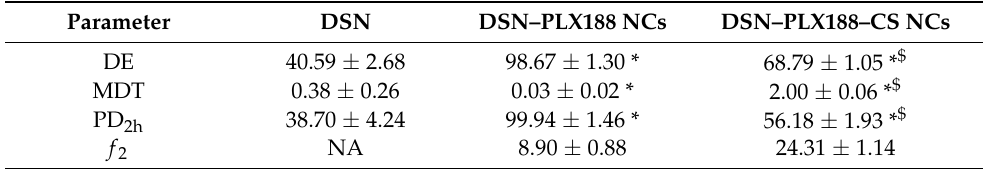
Figure 5. In vitro DSN dissolution up to ( A ) 60 min and ( B ) 8 h from the selected NCs based on PLX188 alone and the PLX188–CS combination in comparison with the drug in a sodium orthophosphate buffer (pH 12), employing the paddle method. Data are expressed as the mean ± SD ( n = 3). Table 4. The dissolution parameters of the selected NCs in comparison with DSN.